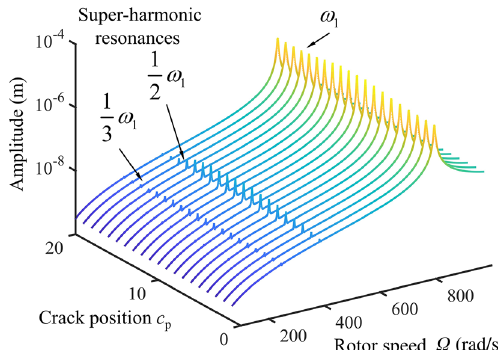
Figure 6 3D waterfall diagram of rotor speed-crack position-amplitude at node 10 ( (cid:31)